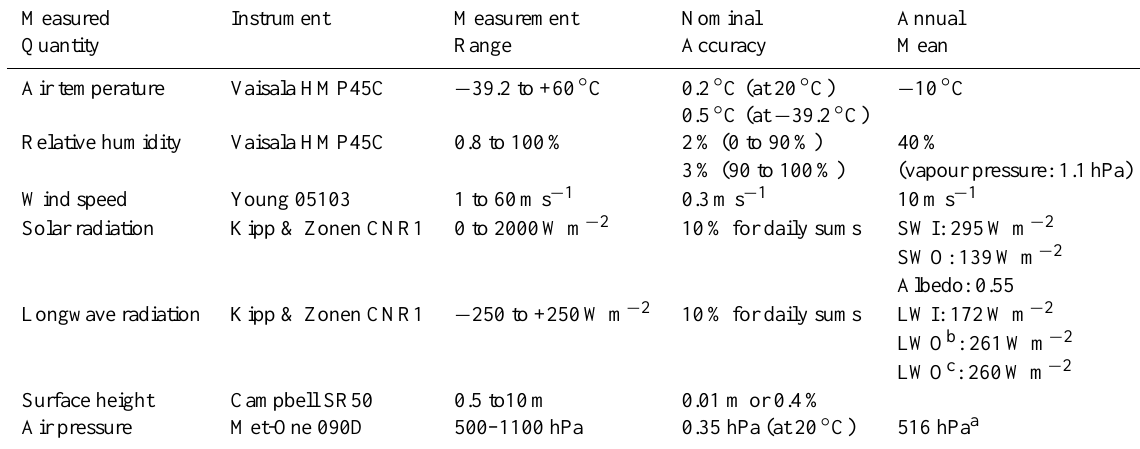
Table 1. Details of the instruments and the annual mean conditions at this site (calculated using data between 1 November 2008–31 October 2010). All measurements were at G-AWS on the glacier surface except for air pressure, which is from a station 3 km away at an elevation of